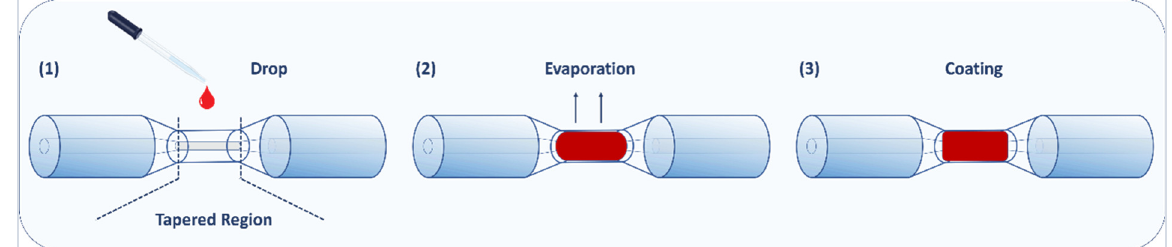
Figure 5. Tapered optical fiber functionalization with Pd/GO nanocomposite using the drop-casting method.